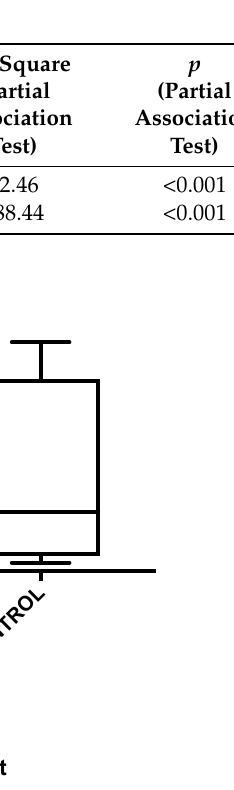
Figure 8. Mean percentages of predation ( n = 4) in sugar dispenser and control treatments. Box plots indicate the median (solid line) and the range of dispersion (the lower and upper quartiles); the whiskers (vertical lines) represent the minimum and maximum predation rates observed. Log linear analysis showed a significant difference of predation rate between the two treatments (*** = p < 0.001).